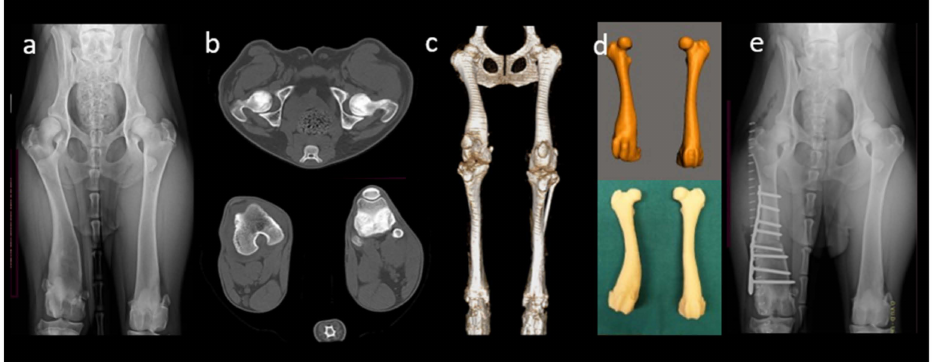
Figure 2. Receiver-specific approach in a 1.5-year-old Doberman with lateral patellar luxation due to complex angular limb deformity involving valgus and internal torsion of the right femur ( a ), radio- graphs). The steps consist of ( b ) image acquisition in DICOM from CT scans; ( c ) image processing including 3D reconstruction and volume rendering with Meshmixer software, and ( d ) 3D printing of anatomical models of both femurs using FFF technique from PLA filaments on a Delta WASP 2040 INDUSTRIAL X 3D Printer (WASP, Massa Lombarda, Ravenna, Italy). CT images and their 3D reconstruction were used to measure angular limb deformity and plan for corrective ostectomy. Models were used for studying the receiver’s anatomy, for surgical rehearsal, and for pre-contouring of the plate before actual surgery. ( e ) Using 3D modeling, medial closing wedge ostectomy and torsional correction were performed more